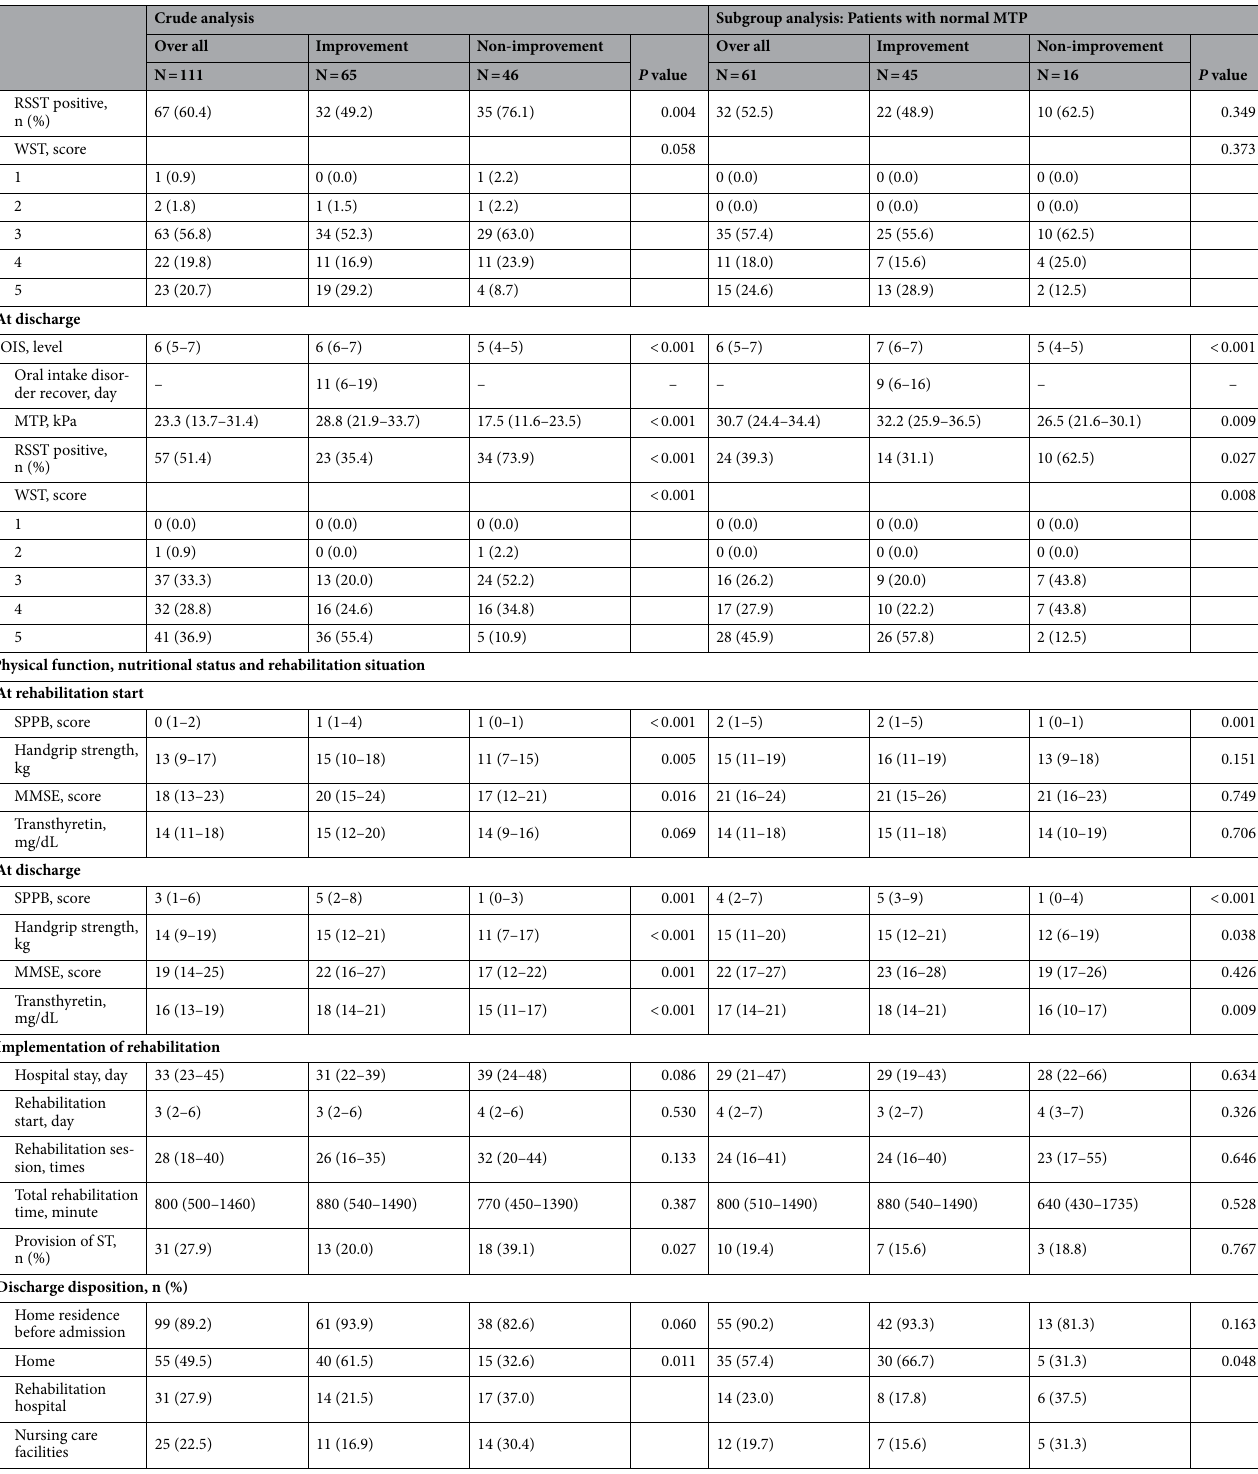
Table 1. Baseline Characteristics. Values are median (interquartile range) or numbers of subjects per group (n) with percentages. ADL Activities of daily living , ACEI Angiotensin converting enzyme inhibitor, ARB